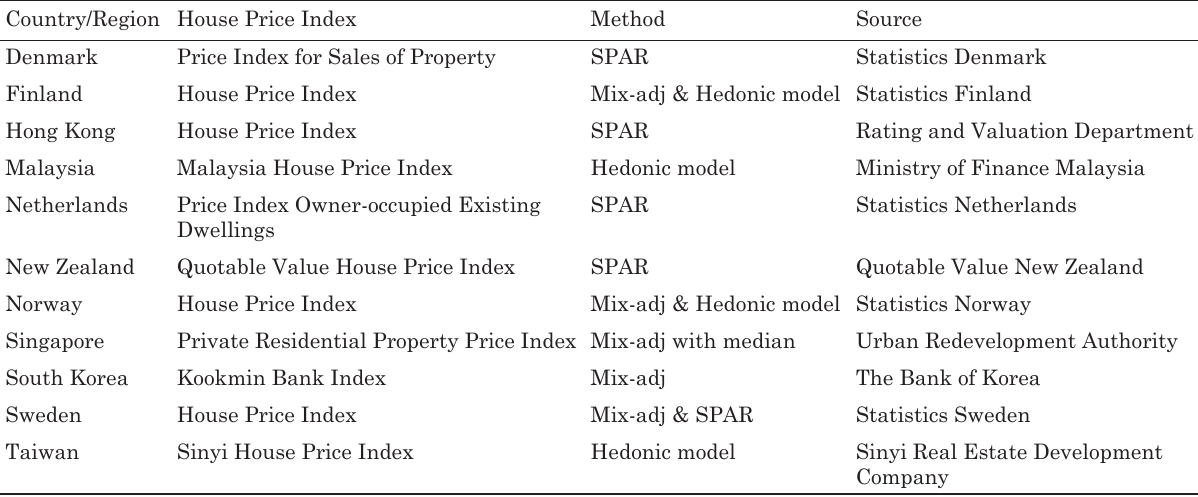
Table 1. Cross countries summaries of house price